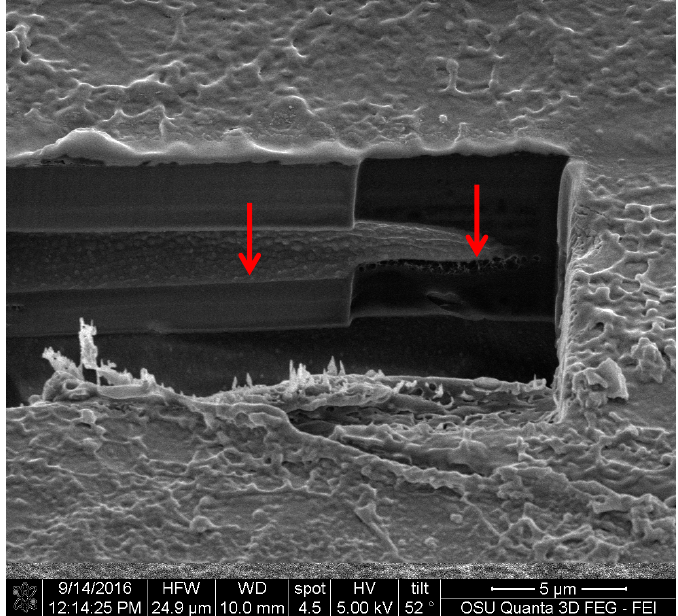
Figure 13. Cross-section of the area between the extracted pigment of S. ganodermophthorum and cottonwood. The left arrow shows an even attachment layer while the right arrow shows a sponge-like surface between the pigment and the wood. FEI QUANTA 3D dual beam SEM/FIB.